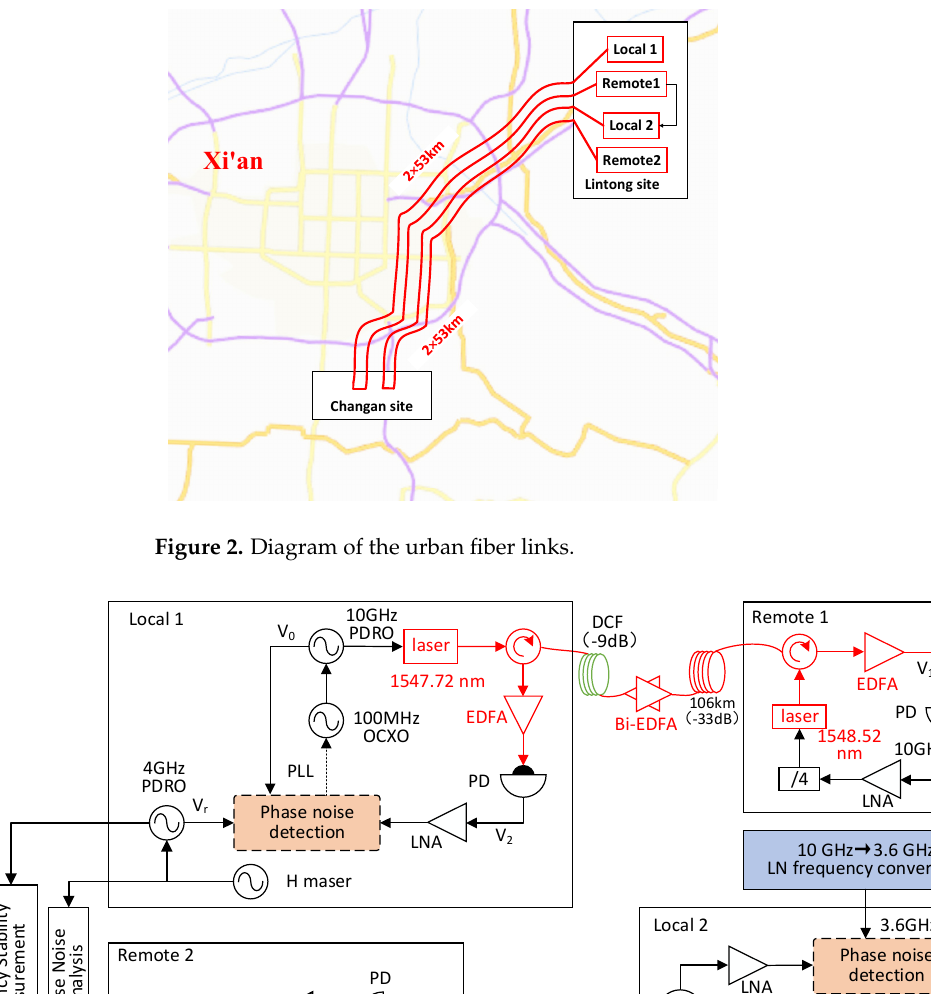
Figure 2. Diagram of the urban fiber links.